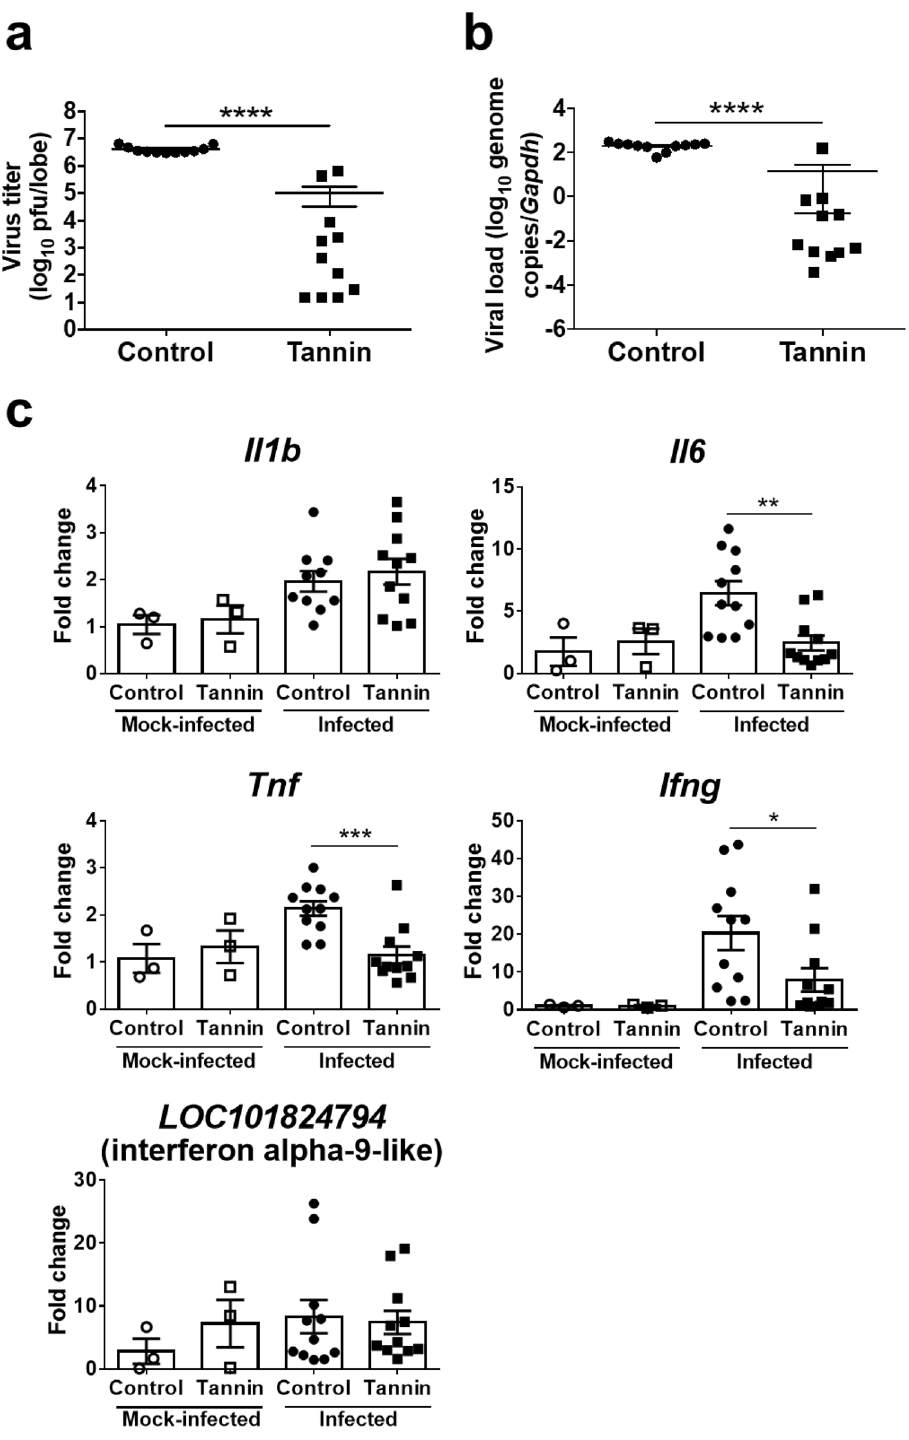
Figure 3. Effect of pre-administration of persimmon-derived tannin on virus titers, viral load, and inflammatory-related gene expression in the lungs of hamsters inoculated with SARS-CoV-2. ( a ) Virus titers were measured by the plaque assay method. The uppermost lobe of the right lung was used and plaque-forming units (pfu) per lobe were calculated. ( b ) Viral load was measured by quantitative PCR. ( c ) Expressions of Il1b , Il6 , Tnf , Ifng, and LOC101824794 (interferon alpha-9-like) were measured by quantitative PCR. RNA extracted from the right lung was used and normalized to Gapdh expression. Data are shown as the mean ± SEM of two independent experiments (mock-infected, control group, n = 3; mock-infected, tannin group, n = 3; infected, control group, n = 11; infected, tannin group, n = 11). *p < 0.05, **p < 0.01, ***p < 0.001, ****p <